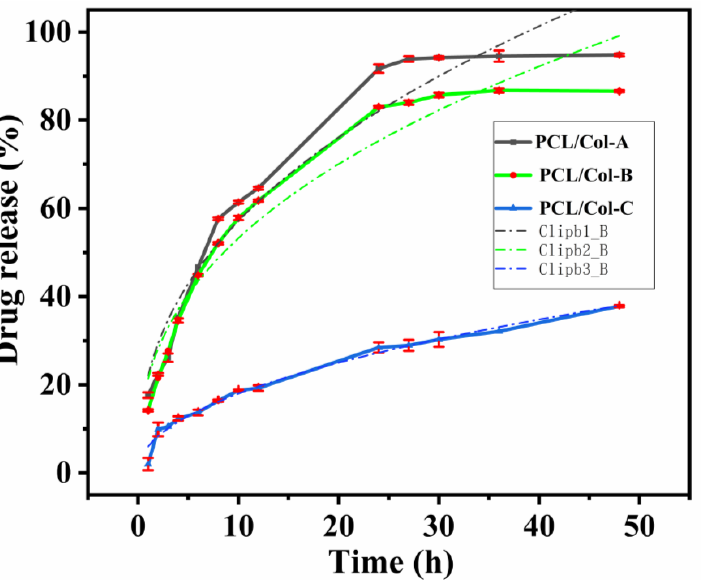
Figure 6. The drug release profile of the ART-loaded PCL/Col nanofibers with different polymer